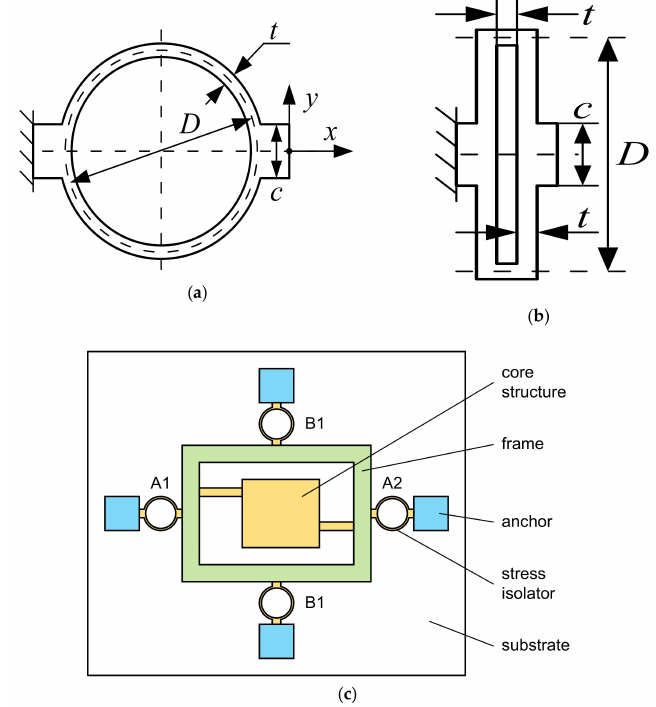
Figure 4. Two types of thermal stress isolator. ( a ) Annular isolator; ( b ) rectangular isolator; and ( c ) the usage of the isolators.